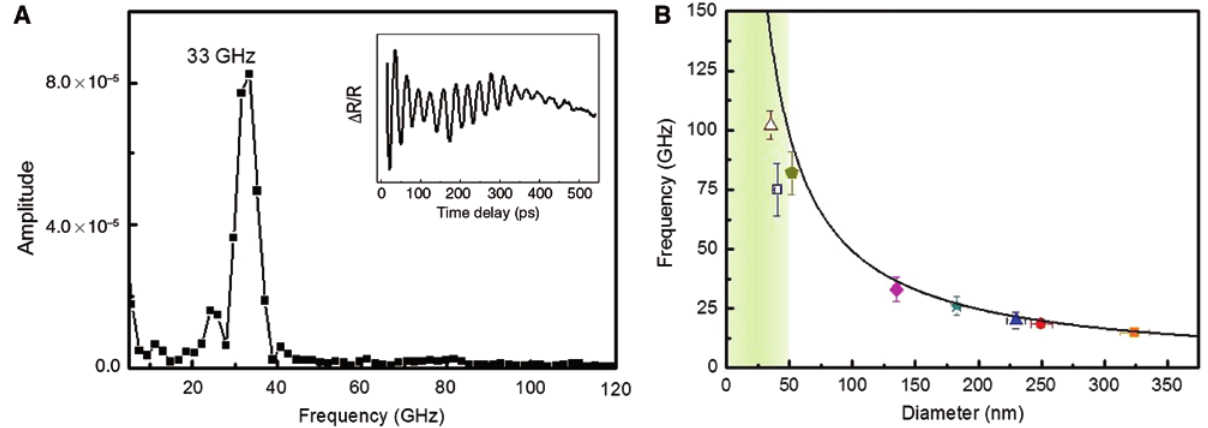
Figure 12: Breathing modes of GaN nanowires. (A) Fourier transform of the transient reflectivity signal obtained on 135 nm diameter GaN nanowire. Inset: transient reflectivity signal after removal of the electronic contribution of a 135 nm diameter GaN nanowire. (B) Frequency of the observed oscillations as a function of the diameter of the nanowire. The black line is the result of the calculation of the breathing mode frequency using Eq. 2. Reproduced from